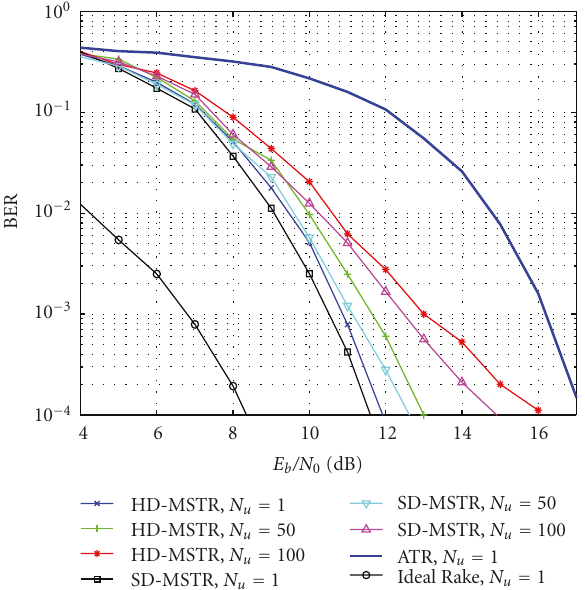
Figure 9: BER of HD-MSTR and SD-MSTR for M = 30, N = 10, and di ff erent N u over random